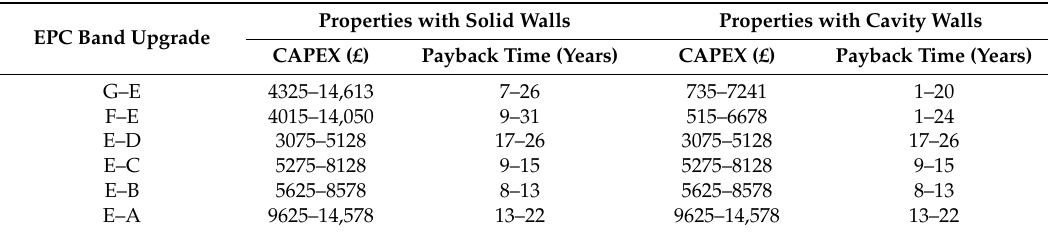
Table 5. Capital cost and payback times of EPC upgrades under the VCT